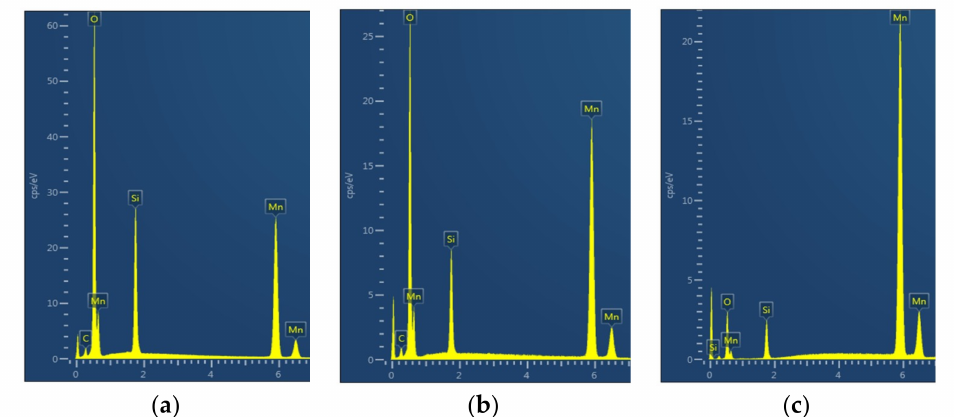
Figure 27. EDS-spectra of Mn / Si = 2 catalyst at various locations: ( a ) Region of average Mn concentration, n = 0 with molar composition: [Mn] 0 = 0.317; [Si] 0 = 0.083; [O] 0 = 0.600; ( b ) Region of lowest Mn concentration, n = 1 with composition: [Mn] 1 = 0.204; [Si] 1 = 0.118; [O] 1 = 0.678; ( c ) Region of highest Mn concentration with composition: [Mn] 2 = 0.772; [Si] 2 = 0.059; [O] 2 = 0.169.